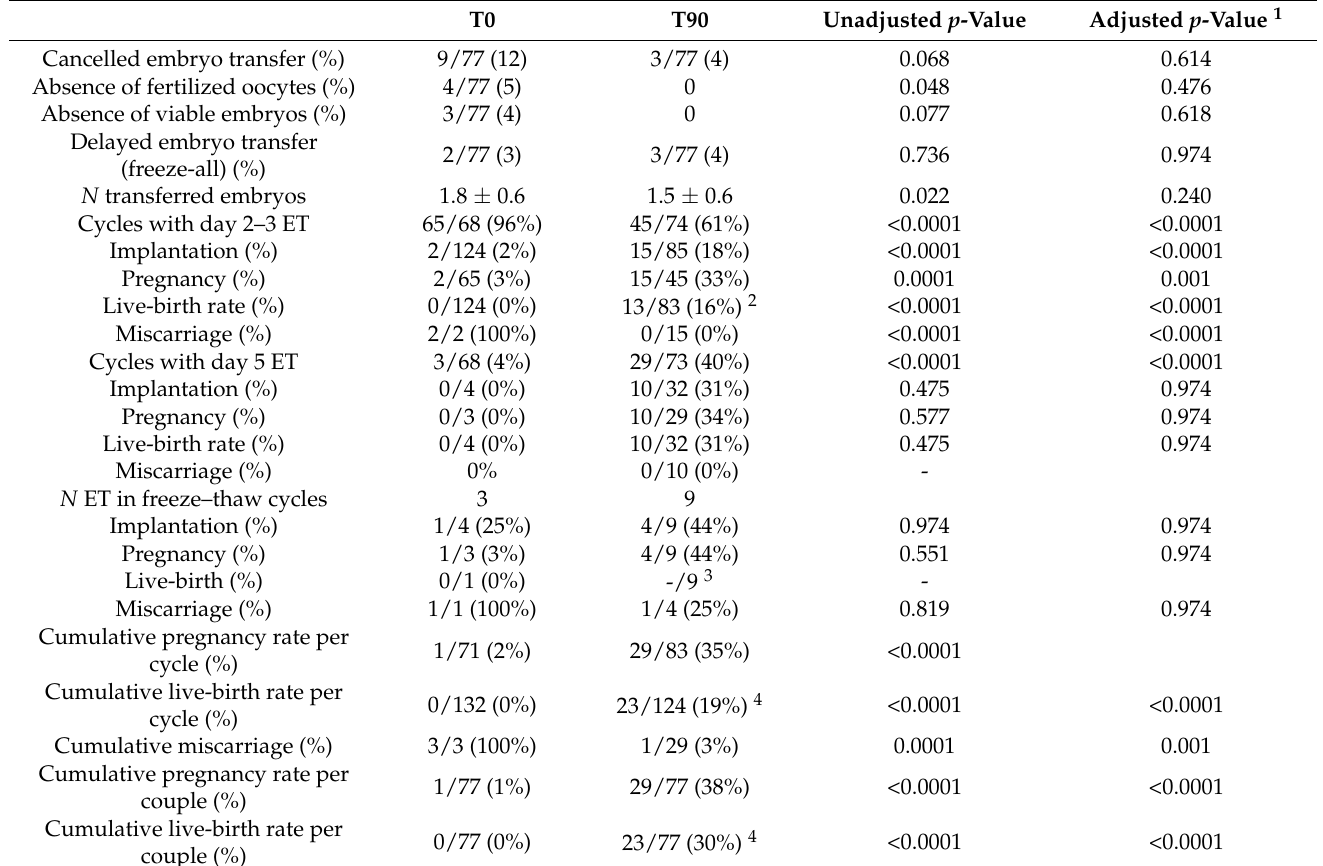
Table 4. Clinical outcomes of T0 and T90